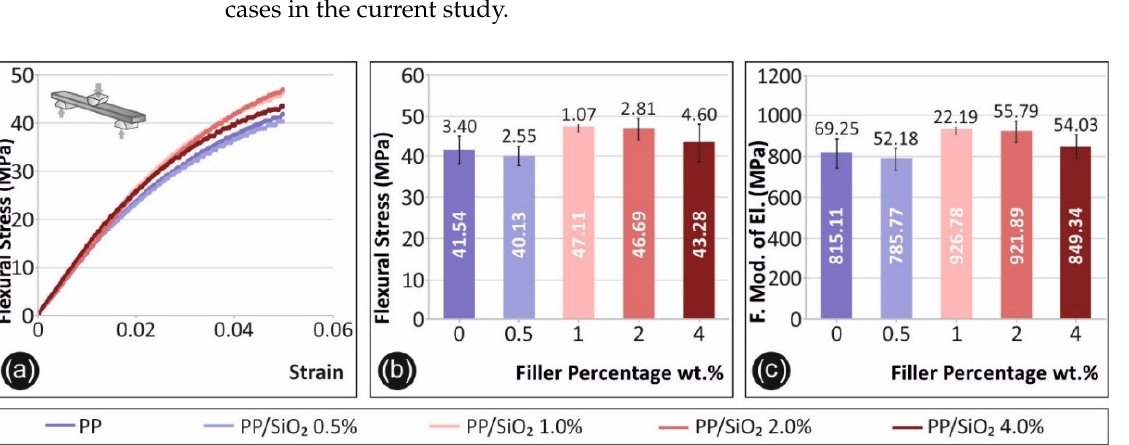
Figure 4. Flexural test results: ( a ) flexural stress (MPa) to strain (%) graph, for a characteristic specimen of each material fabricated, ( b ) average maximum flexural stress (MPa) and its deviation for the materials tested, ( c ) average flexural modulus of elasticity (MPa) and its deviation for the materials tested.